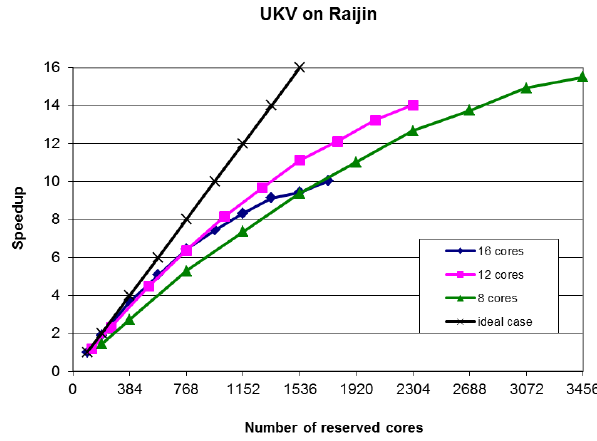
Figure 4. Speedup as a function of number of reserved cores on Raijin. Speedup was calculated in relation to the elapsed time of 9523s obtained for a 96-core run on fully committed nodes.